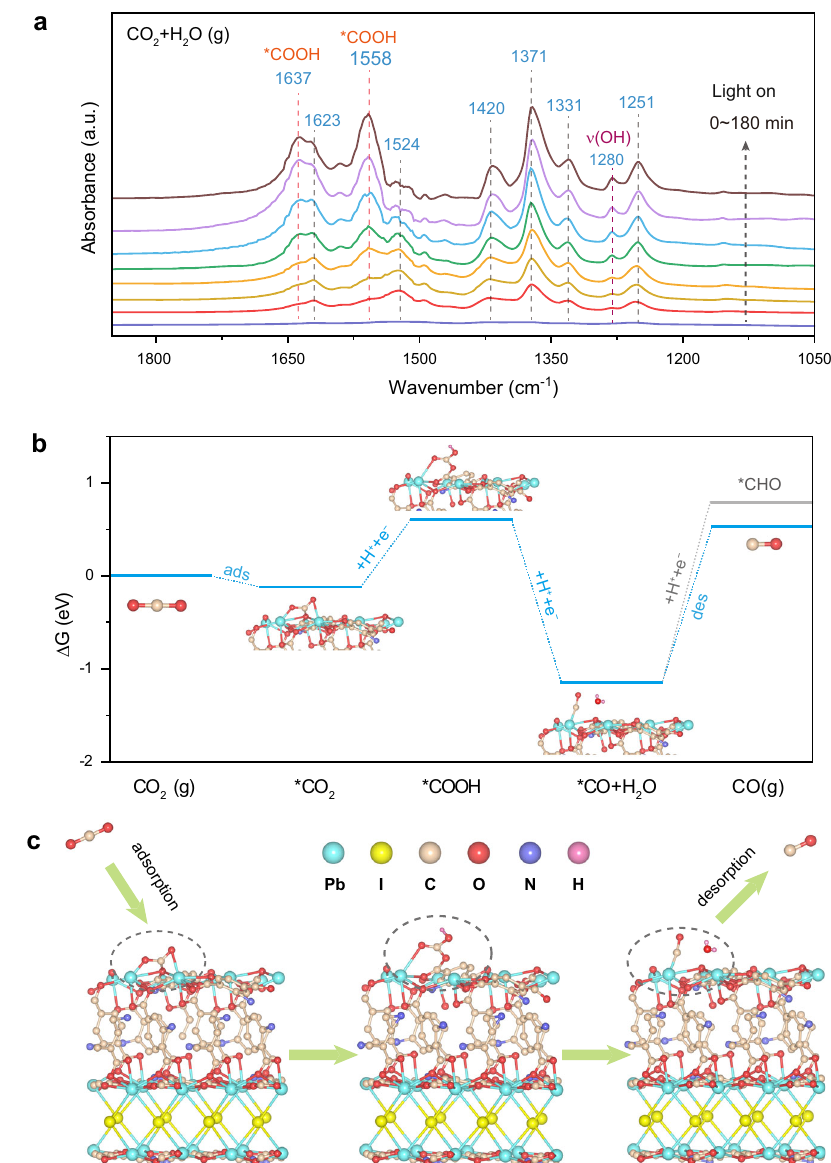
Fig.6|InsituDRIFTSmeasurementandGibbsfreeenergycalculations.a Insitu DRIFTS spectra for co-adsorption of a mixture of CO 2 and H 2 O on the TMOF-10- NH 2 (I). b Calculated free energy ( Δ G) diagram of CO 2 photoreduction to CO for